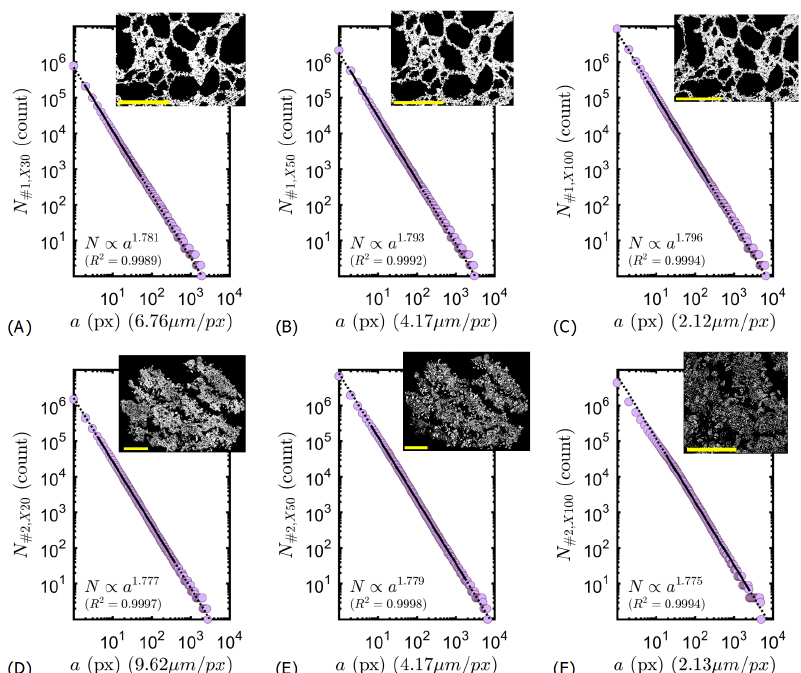
Figure 4. Box count results. Specimen #1: Epoxy char cross-section at ( A ) × 30, ( B ) × 50, ( C ) × 100 magnifications. Specimen #2: Silicone char cross-section at ( D ) × 20, ( E ) × 50, ( F ) × 100 magnifications. All scale bars are 5